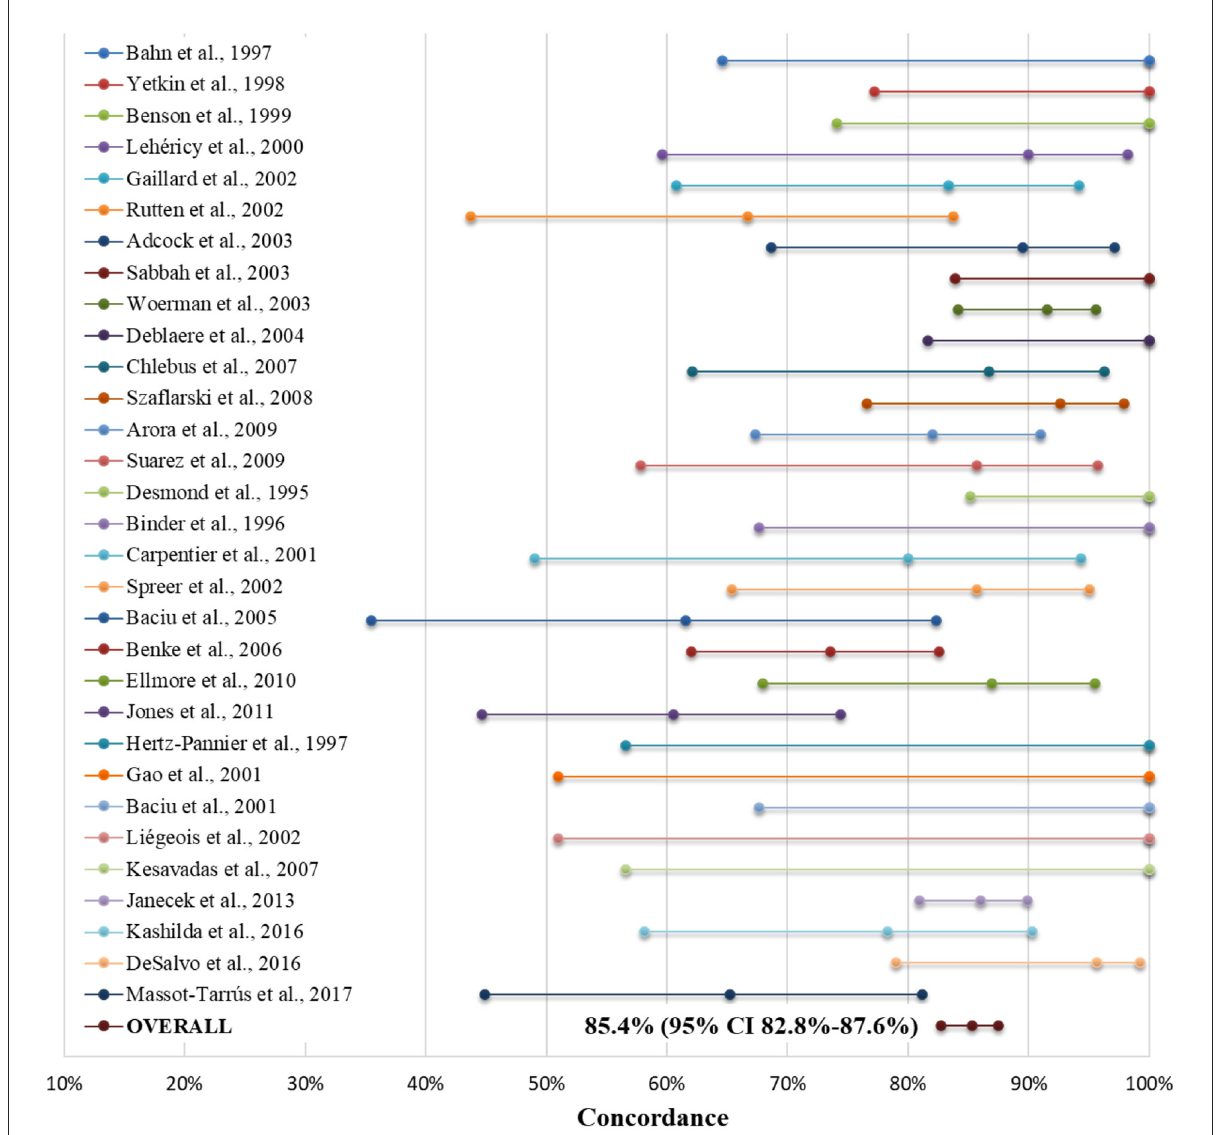
FIGURE2 Forest plot indicating concordance between the Wada test and fMRI for language lateralization (as mean estimates and confidence bars) in each of the 31 studies included in our meta-analysis, both separately and as the sum of all patients (as "Overall"). For further details, see Massot-Tarrús et al., (5). Adopted with minor modifications from the original figure published in Massot-Tarrús et al. (5).